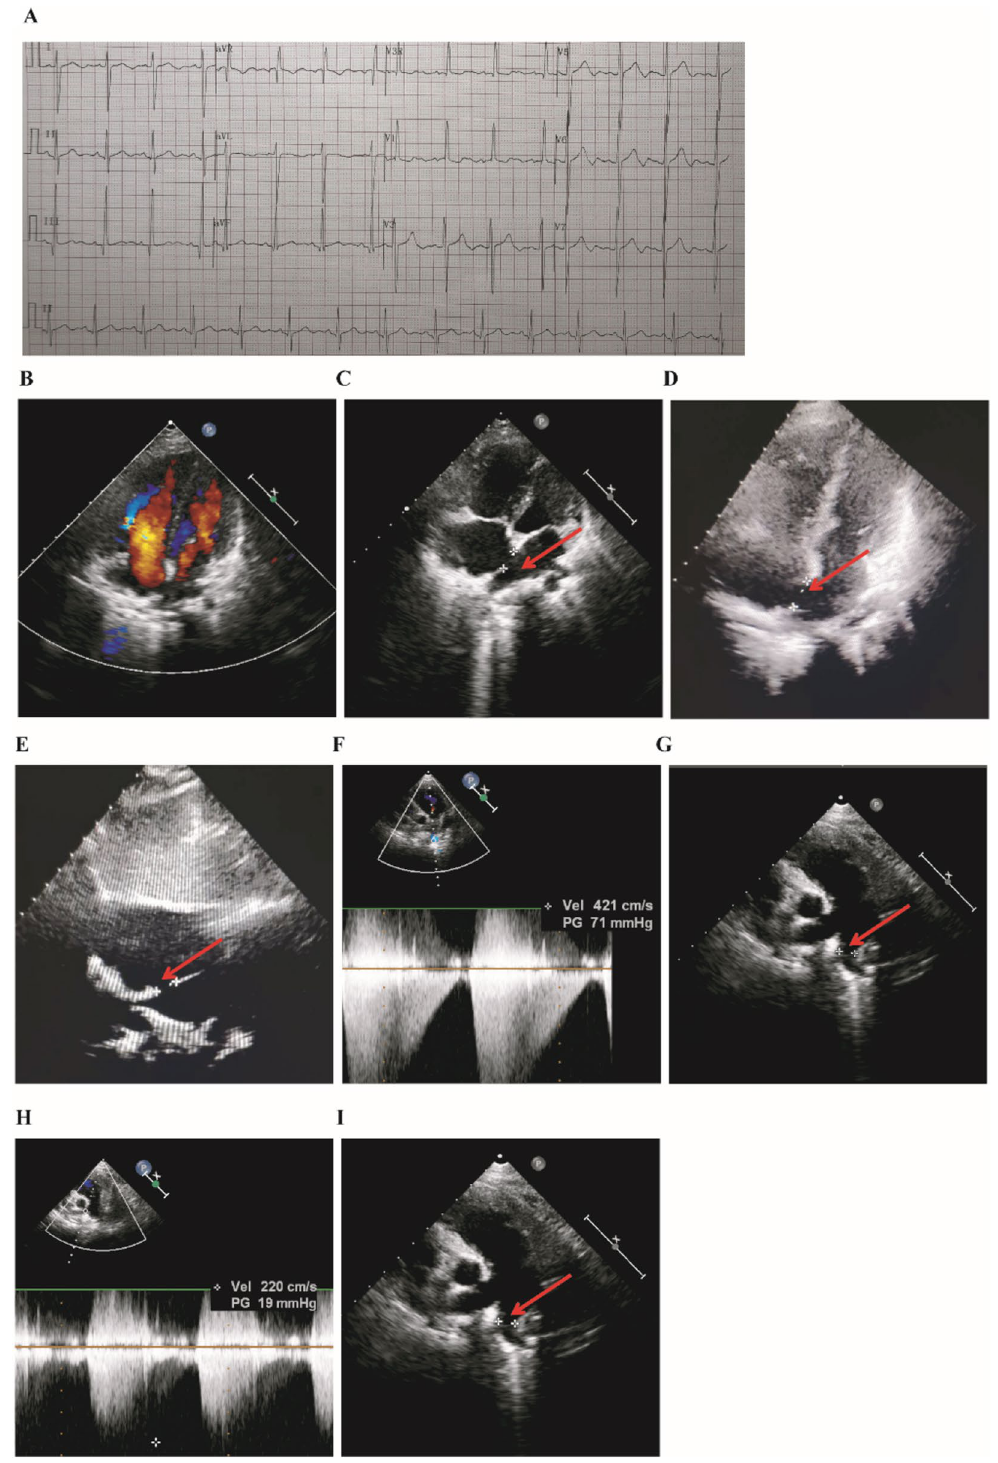
Figure 1. 12-lead ECG and ultrasonic cardiogram in the patient. ( A ) 12-lead ECG in resting time showing sinus arrhythmia; slight hypertrophy (RV5/SV1 = 1.51/0.00 mV) evident in the right ventricular. ( B – I ) Ultrasonic cardiogram of the patient. The red arrow indicates the site of an atrial septal defect in the left and right pulmonary